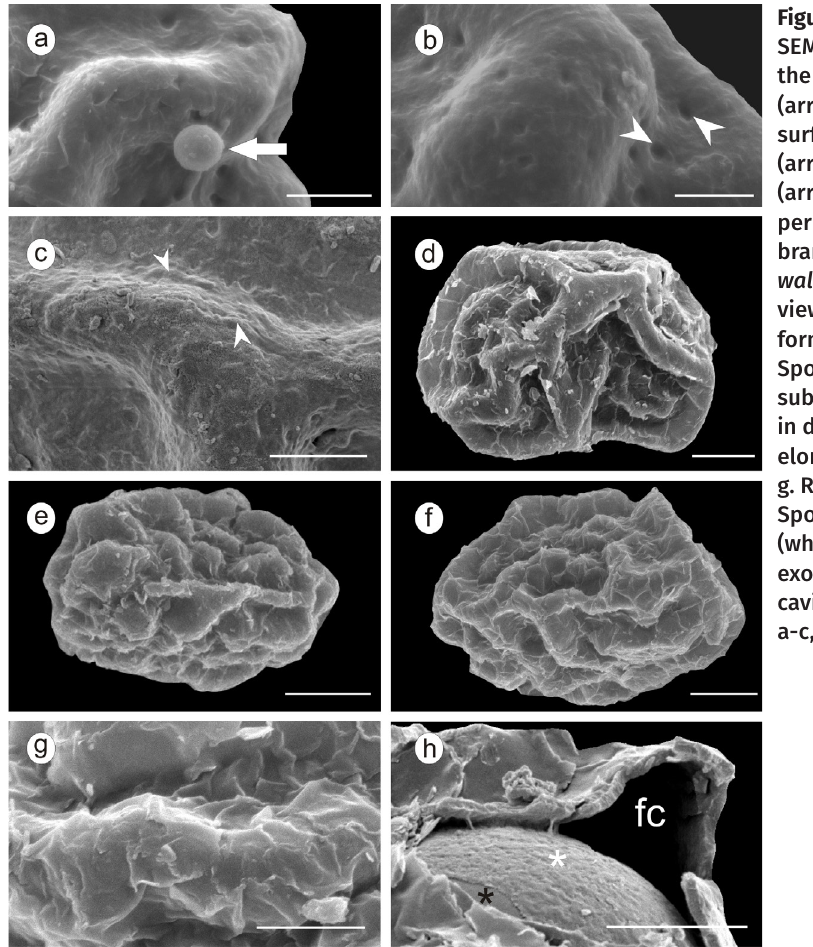
Figure 3. Spores of Dryopteris with SEM. a-c: D. patula a. Spheroid at the perispore surface is observed (arrow). b. Foveolate perispore surface. Small depressions (arrowheads) are seen. c. Rugulae (arrowhead) are seen in the perispore surface. A coarse fold branched is observed. d-h: D. wallichiana d. Spore in equatorial view with elongated folds forming irregular reticulum. e. Spore in proximal view. Inflated, subglobose folds are seen. f. Spore in distal view. Subglobose, inflated, elongated folds are observed. g. Rugulate perispore surface. h. Sporoderm fracture. The base of fold (white asterisk) covers the smooth exospore (black asterisk). The fold cavity (fc) is observed. Scale bars: a-c, g-h = 5 µm; d-f =10